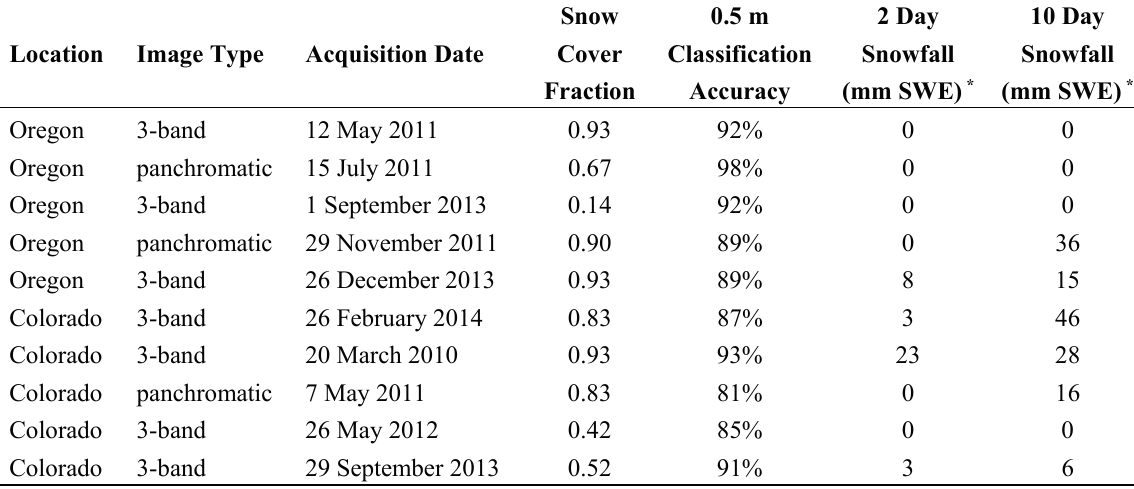
Table 2. Study area, image type, date, snow cover fraction, 0.5 m binary SCA classification accuracy, and recent snowfall history (in terms of snow water equivalent, SWE) for each WorldView (panchromatic) or WorldView-2 (3 band) image strip included in the